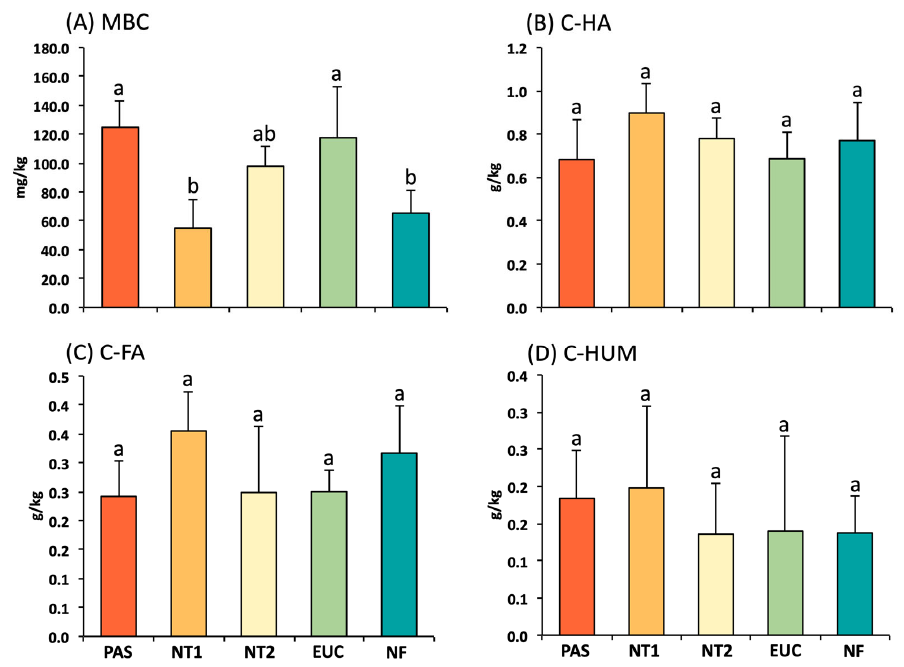
Figure 2. Microbial biomass carbon (MBC) ( A ), humic acid (C-HA) ( B ), fulvic acid (C-FA) ( C ), and humin (C-HUM) ( D ) fractions in the 0–0.10 m depth. Vertical lines on the bars indicate standard errors of means ( n = 5). Treatments with different letters on the bars are significantly different ( p ≤ 0.05) by the Tukey test. PAS: Pasture species (Mombasa); NT1 and NT2: No-tillage system; EUC: Eucalyptus; and NF: Native Cerrado